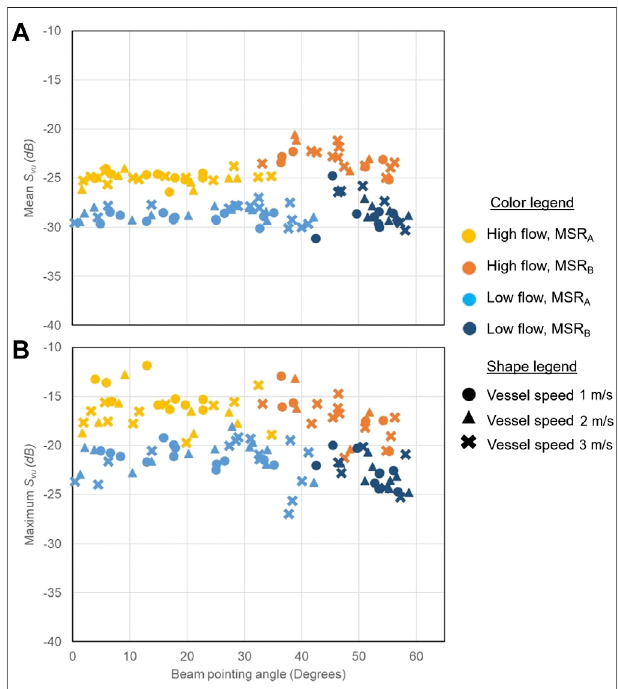
FIGURE 12 | (A) Mean S vu values plotted by beam pointing angle. Circles represent data collected at 1 m/s, triangles at 2 m/s and crosses at 3 m/s. High fl ow refers to 2.0 L min − 1 and Low fl ow refers to 0.2 L min − 1 . MSR A are samples above the minimum slant range, and MSR B are samplesthatarebelow(withintheareaofreceiverarraysidelobeinterference). (B) Maximum S vu values plotted by beam pointing